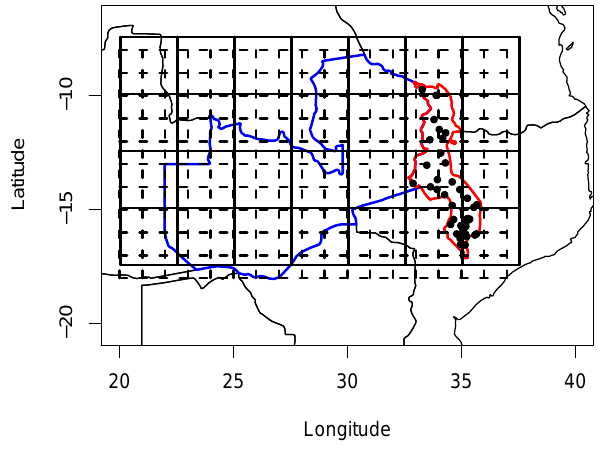
Figure 1. The map of the study area, where Malawi (red lines) and Zambia (blue lines) are emphasized. The grids used for subjective digitalization of forecasts are also shown, the 1 . 0 ◦ × 1 . 0 ◦ grid in dashed line and the 2 . 5 ◦ × 2 . 5 ◦ grid in solid line. Black dots show the stations with in-situ observations in